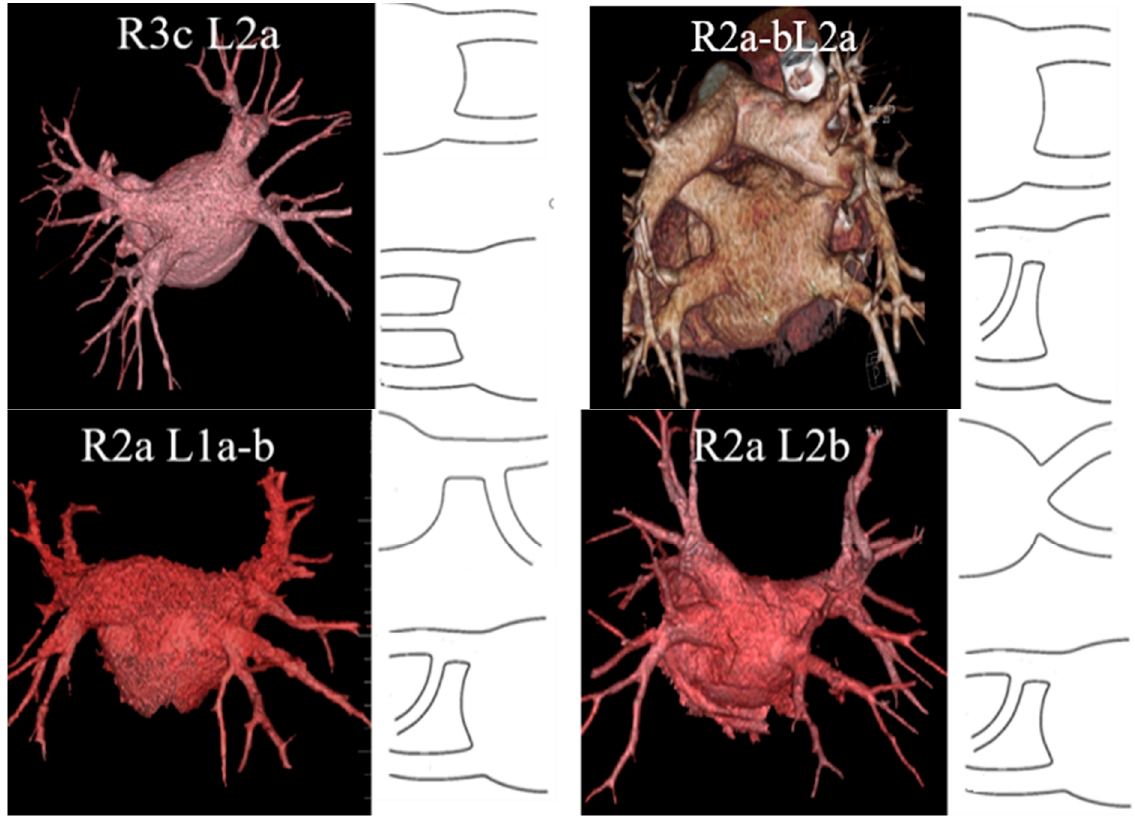
Figure 3. А natomical variants of PV according to E.M. Marom et al. [18]. Figure 3. Anatomical variants of PV according to E.M. Marom et al. [18]. Table 1. Clinical characteristics of the